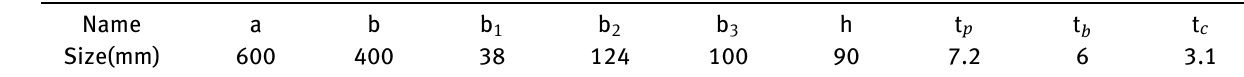
Table 2: Dimensions of stiffened composite panels at